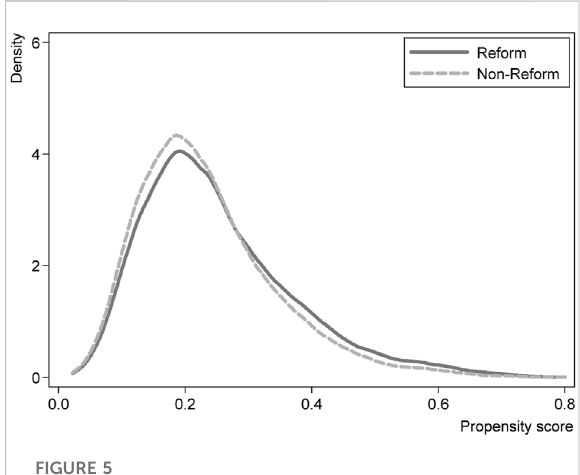
FIGURE 4 Density plot before matching for the share of state capital (0,1).